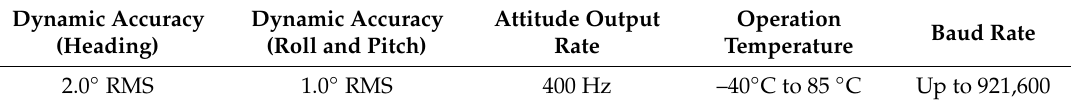
Table 4. Specification of the VN-100 Rugged AHRS board.